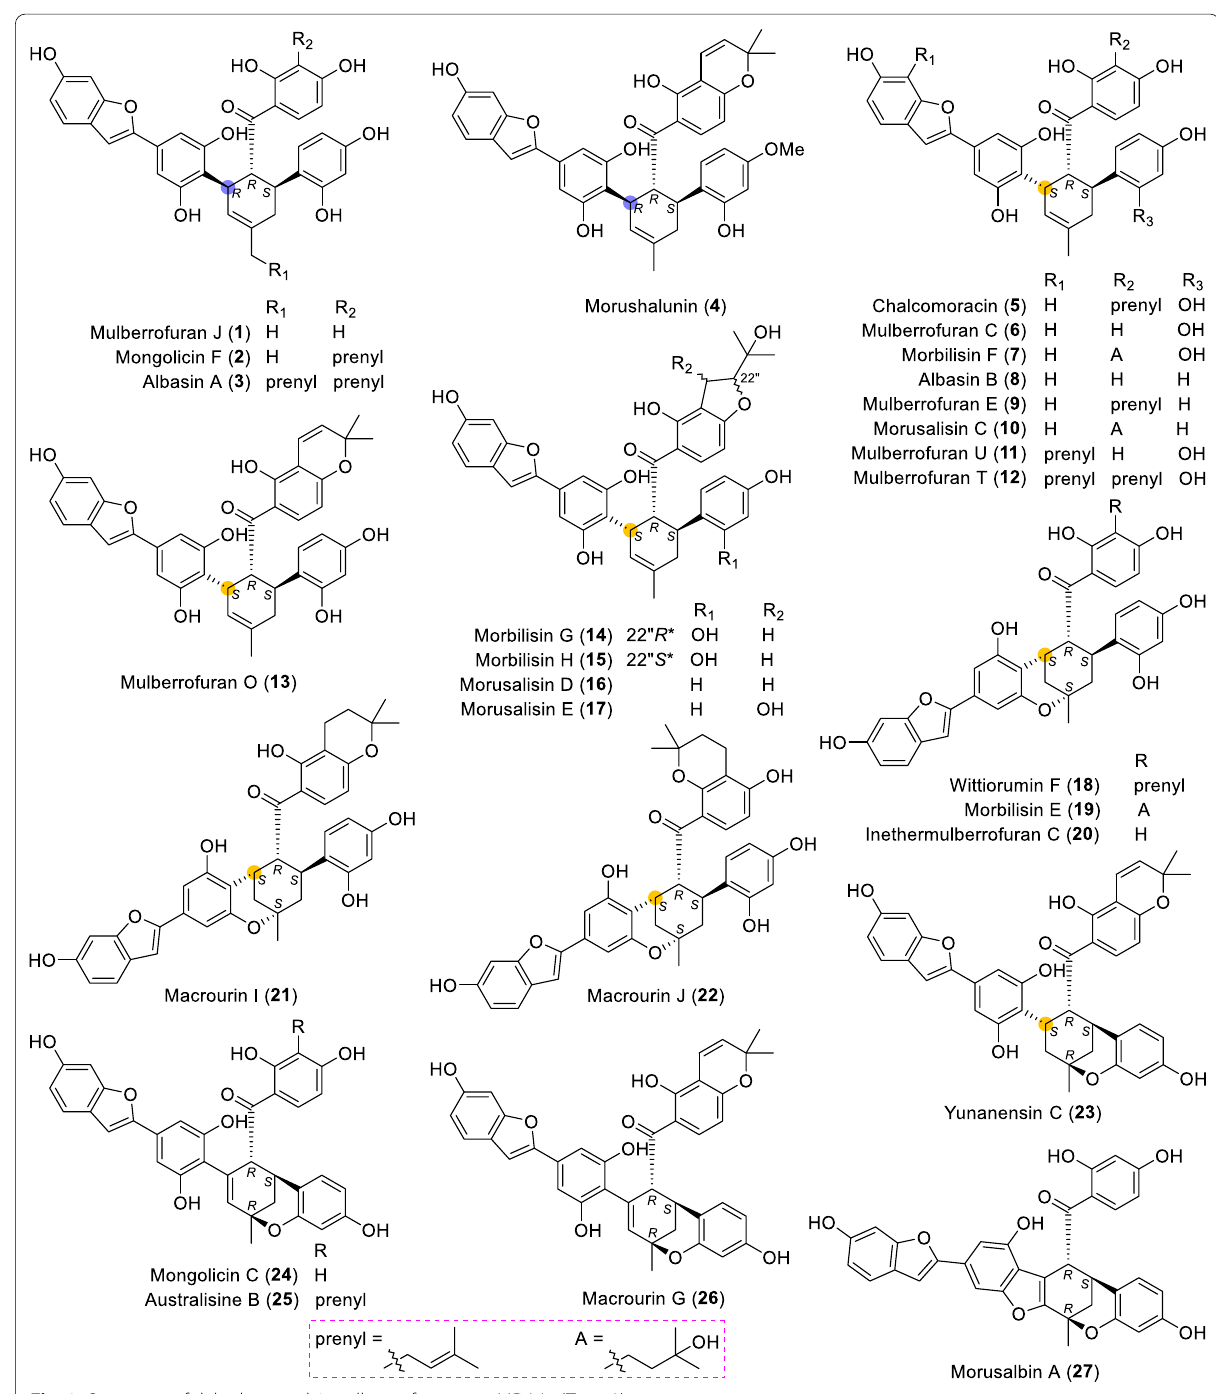
Fig. 2 Structures of dehydroprenyl‑2‑arylbenzofuran type MDAAs (Type